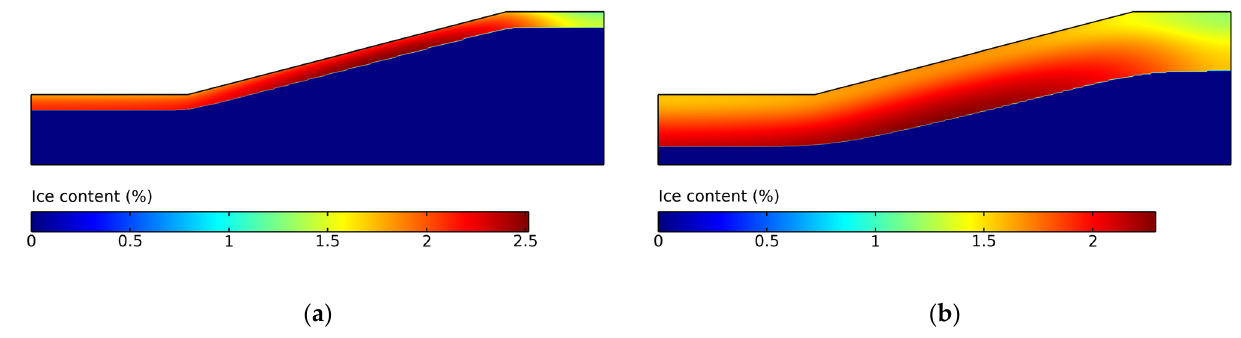
Figure 7. Ice content distribution of the soil at ( a ) 20 h and ( b ) 80 h.